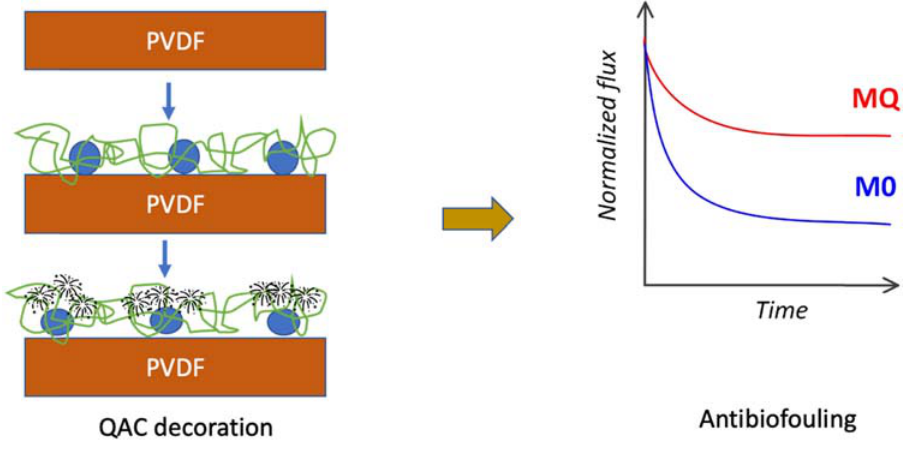
Figure 4: PVDF membrane modi fi ed via electron transfer ARGET ATRP method [ 85 ]